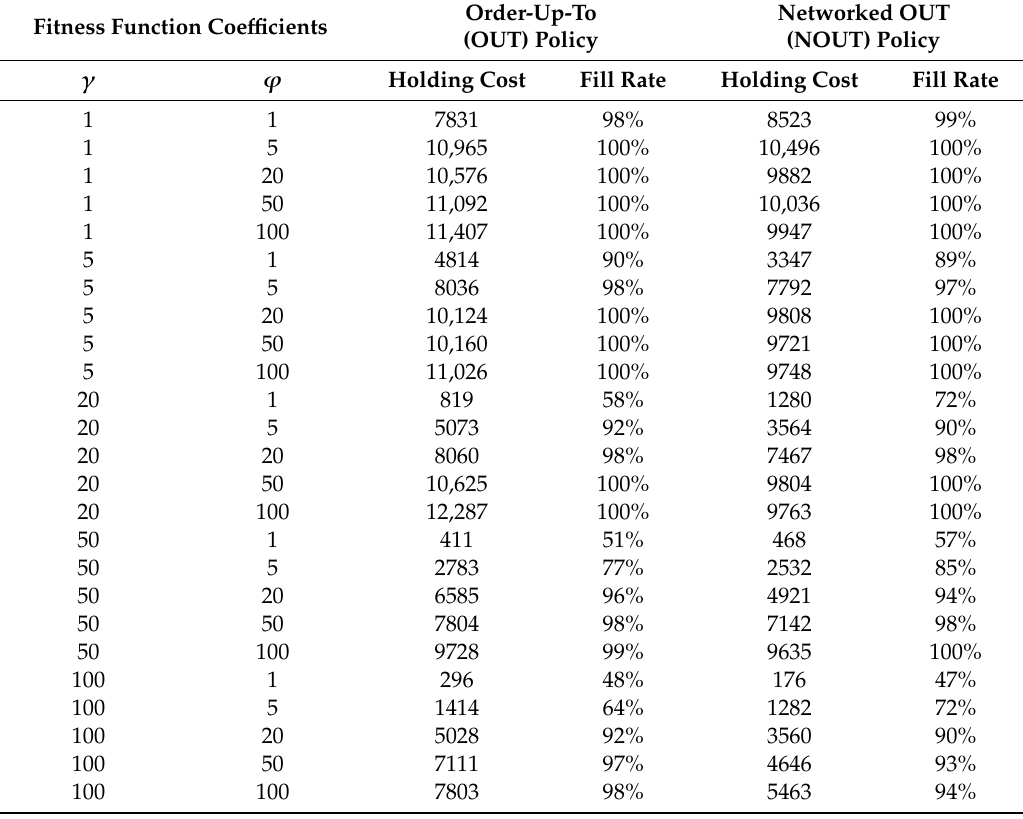
Table 8. Policy performance in network